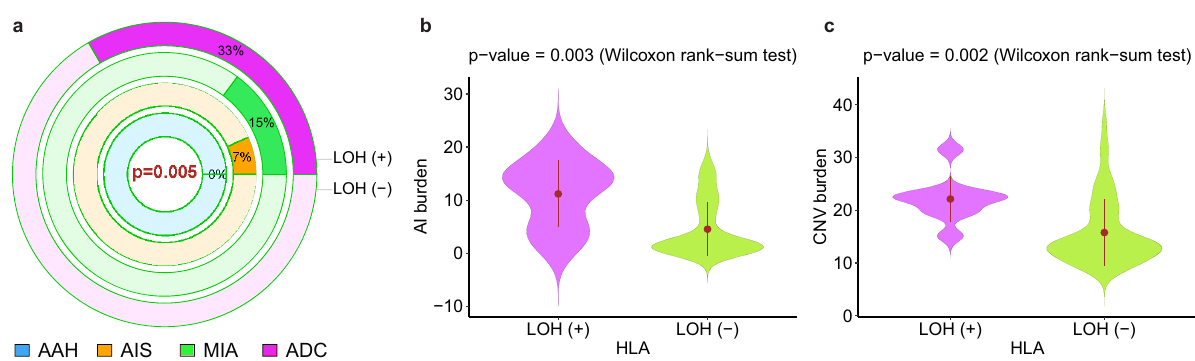
Fig. 5 Loss of heterozygosity in HLA (HLA LOH) in IPNs of different histologic stages and its association with chromosomal alterations. a The proportion of AAH, AIS, MIA, and ADC lesions with evidence of HLA-LOH. Two-sided χ 2 test was used to assess the difference among different histologic stages. Comparison of AI burden (number of AI events) ( b ) and CNV burden (normalized as the percent of genes with CNV) ( c ) in lesions with (purple) and without (green) HLA-LOH. Two-sided Wilcoxon rank-sum test was used to assess the differences. Error bars indicate 95% con fi dence intervals and solid point represent mean value in each stage. Data from 35 patients was used including NL (normal lung tissue), AAH (atypical adenomatous hyperplasia), AIS (adenocarcinoma in situ), MIA (minimally invasive adenocarcinoma), ADC (invasive adenocarcinoma). (Source data is provided as a source data fi le).